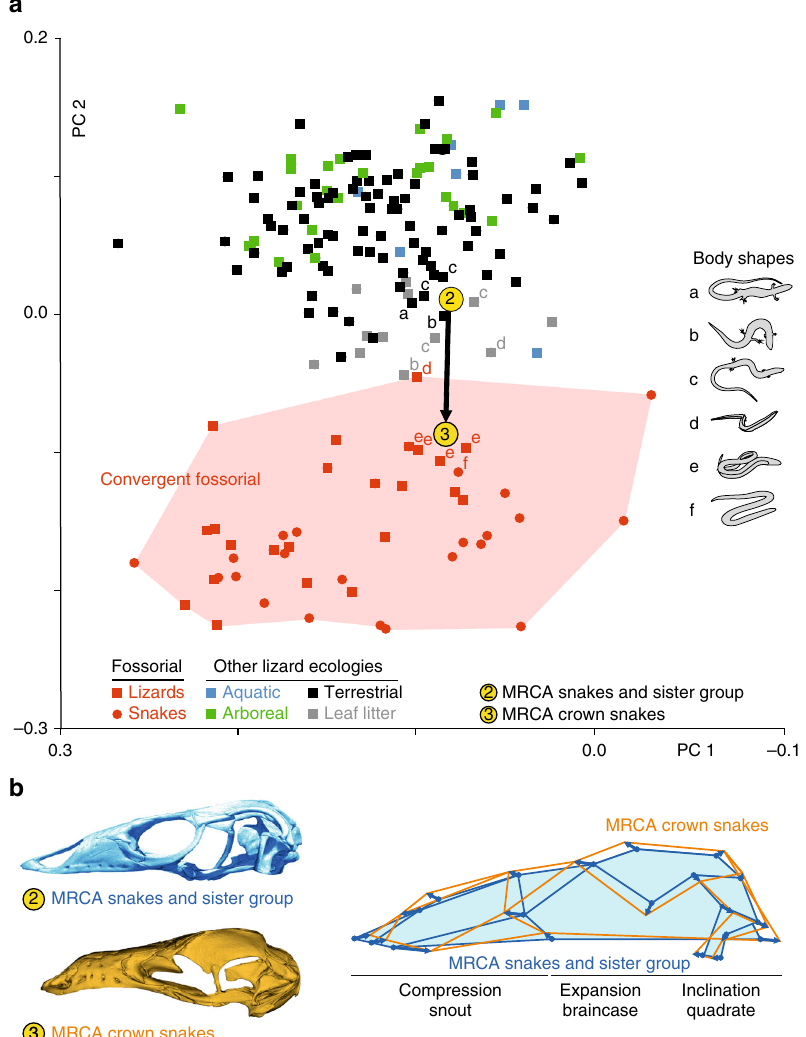
Fig. 4 Ecological analysis of squamate skull evolution. a The habitat preferences of squamates were plotted onto the phylomorphospace presented in Fig. 3. For clarity, branches of the phylogenetic tree are absent, and only lizard (squares) and snake (circles) species located near the reconstructed MRCA of snakes and their sister group and MRCA of crown snakes (yellow nodes 2 and 3, as in Fig. 1) are shown. The thick bold arrow indicates the estimated lizard- to-snake transition. In contrast to other fi gures, the color code re fl ects here different ecologies. Red shading indicates the region occupied by convergent fossorial snake and lizard species. Body shapes of species near the reconstructed MRCAs are indicated by letters (see legend in right panel with schematic shapes: a, typical lizard-like body; b, reduced forelimbs; c, reduced forelimbs and elongated body; d, no forelimbs, reduced hindlimbs, and elongated body; e, no limbs, elongated body; f, legless snake-like body). b Warped skull surfaces of reconstructed MRCAs of snakes and their sister group (blue color, upper left panel) and crown snakes (orange, bottom left panel), and superimposed skull outlines highlighting shape differences between these two MRCAs (right panel); blue vectors re fl ect the direction and magnitude of landmark displacement, and major skull shape changes are indicated below the corresponding skull